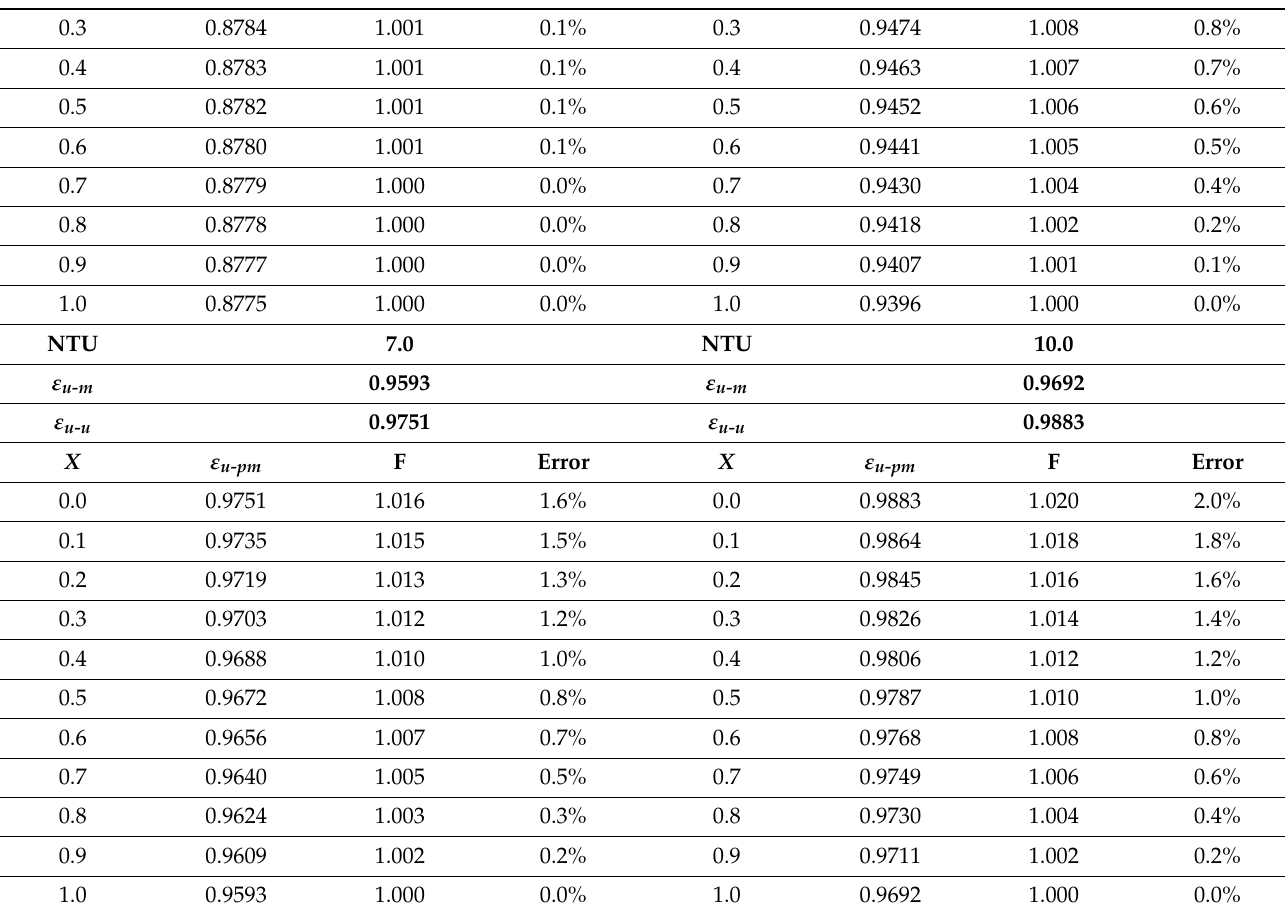
Table A2. Effectiveness correction factor “F” and Error in effectiveness estimation—3-row pure cross flow heat